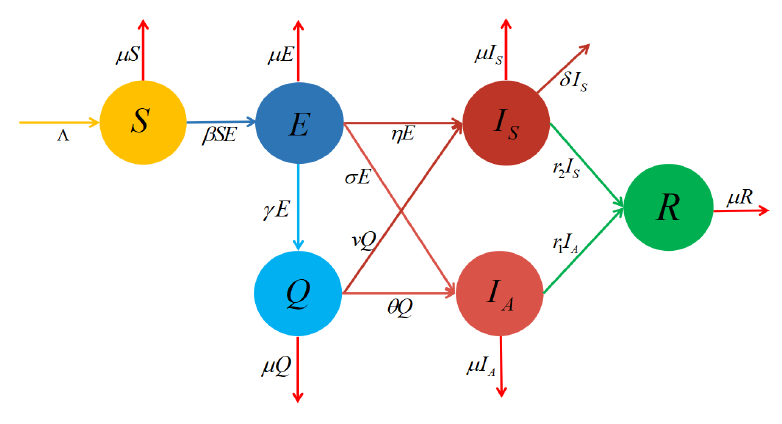
Figure 1. Description of the spread of